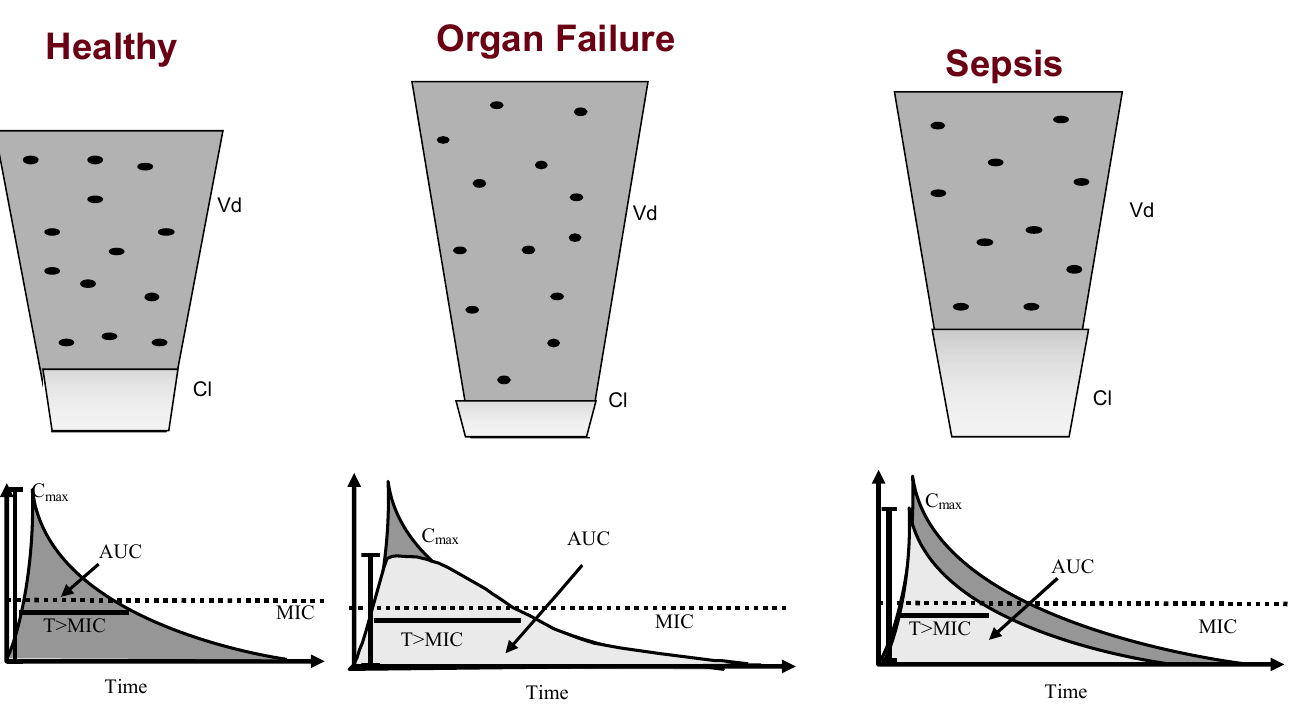
Figure 1. Changes in pharmacokinetics of drugs (including antibiotics) in critically ill patients. During organ failure, changes in water metabolism often lead to an increase in the volume of distribution and a lower concentration. Conversely, clearance is commonly decreased, and a longer half-life is expected. In sepsis, both the volume of distribution and clearance may be increased, and all pharmacokinetic/pharmacodynamic targets are decreased. Vd—Volume of distribution; Cl—Clearance; Cmax—Maximum peak concentration; AUC—Area under the curve; T > MIC—Time above minimal inhibitory concentration (adapted from [25]).